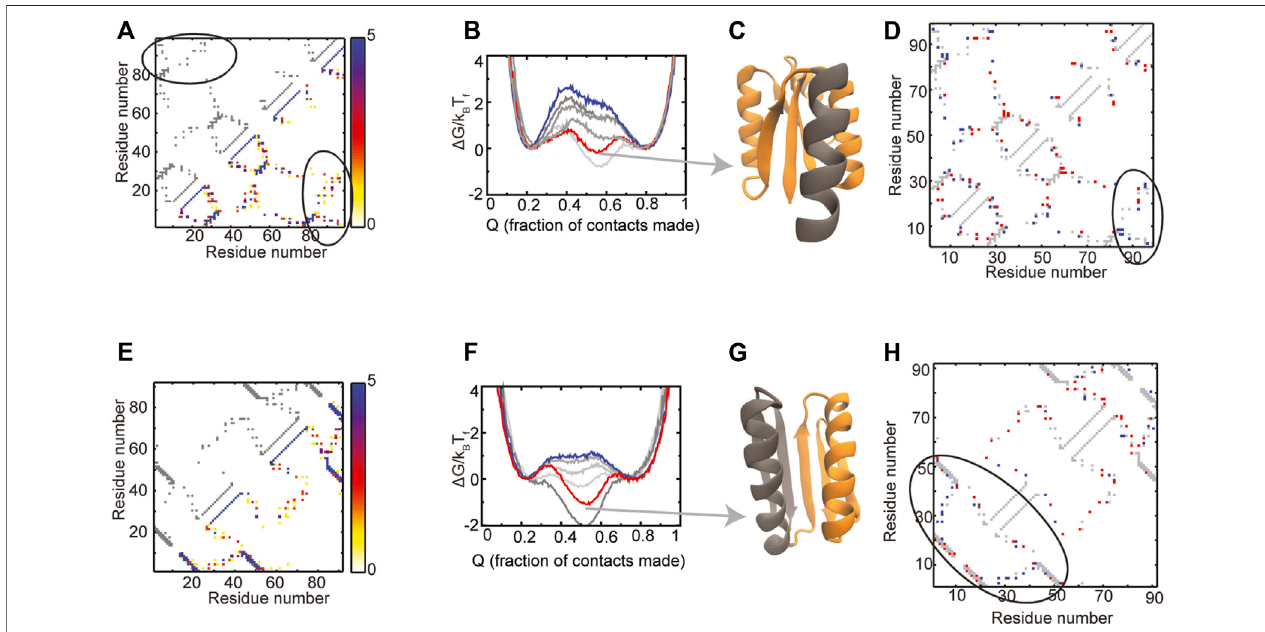
FIGURE 6 | Proteins with populated intermediates. (A – D) Rossmann 3X1 (E – H) Top7. The contact map of the WT is shown in grey in the upper left triangle. The composite contact map of fi ve RPs of the protein is shown in the lower right triangle. The color represents the number of RPs that a given contact is present in with the color scale being given on the right. The ellipses in (A) mark the contacts between the C-terminal helix and the rest of the Rossmann 3X1 protein. (B,F) Scaled free energiesoftheWT(red) and four RPs(different shades ofgrey) areplotted asafunction ofthefraction ofnativecontacts oftheindividualproteins.TheWT proteins have intermediate ensembles which are populated as much or more than the unfolded and the folded ensembles. Random permutation creates proteins which fold cooperativelywithasinglefreeenergybarrier.Thescaled freeenergyoftheRPwiththelargestfreeenergybarrierisshown inblue. (C,G) Arepresentativestructurefrom theintermediateensembleisshownwiththefoldedregionscoloredinorangeandtheunfoldedregionscoloredingrey. (D,H) AdifferencecontactmapoftheWTandthe RP with the highest barrier is shown to determine regions which are better packed in the RP. Grey contacts are common to both the WT and the RP. Red contacts are presentonlyintheWTandbluecontactsarepresentonlyintheRP. (D) ThereisavariationbetweenthenumberandpositionofcontactspresentbetweentheC-terminal helixandtherestoftheprotein(enclosedbytheblackellipse). (H) TheN-terminalregion(blackellipse)gainsseveralbluecontactsintheTop7RPandearlierstudieshave shown that these contacts increase the free energy barrier in Top7 (Yadahalli and Gosavi, 2014). Panels (E) and (F) contain replotted data from our previous work (Yadahalli and Gosavi, 2014; Copyright 2013 by John Wiley and Sons, Adapted with